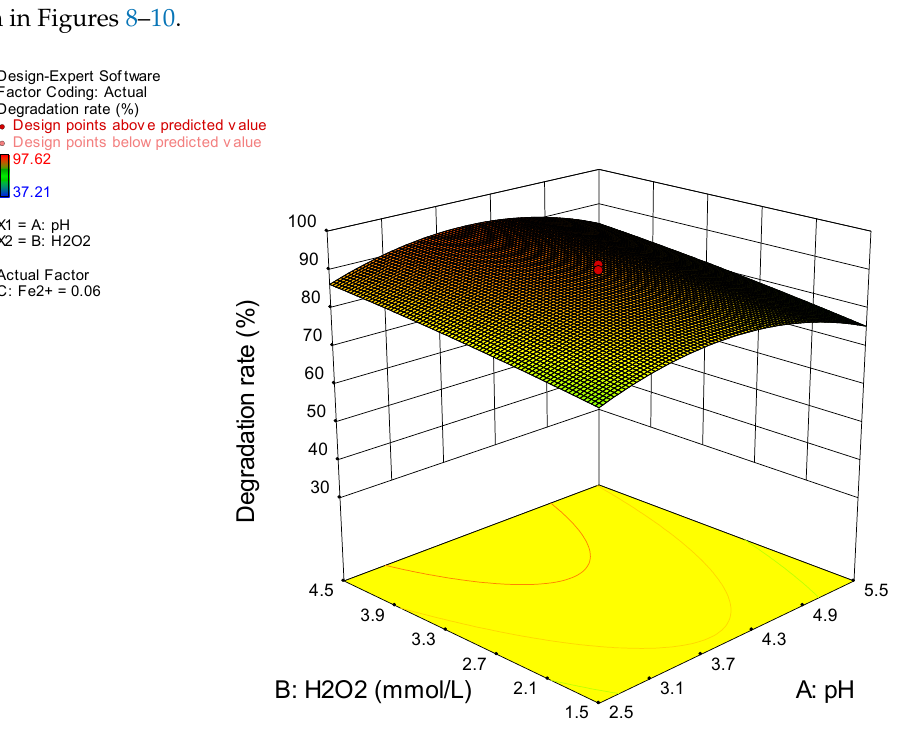
10 of 14 Table 3. ANOVA results for the trimethoprim degradation model; df—degrees of freedom. Source